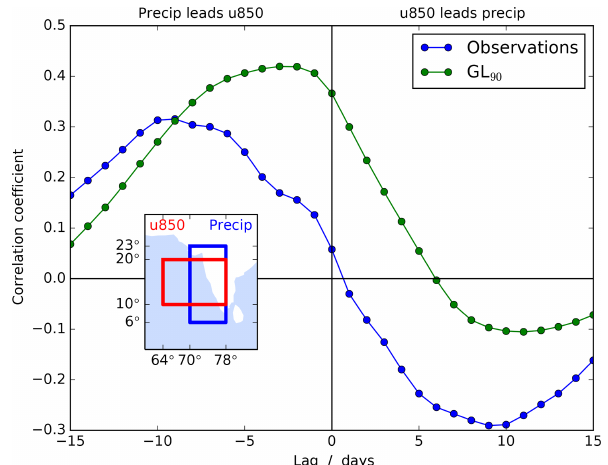
Figure 11. Lag correlation of precipitation and u 850 averaged over the boxes shown (inset) for boreal summer (June to Septem- ber) from observations (GPCP precipitation and ERA-Interim wind, 1997–2010) and GL 90